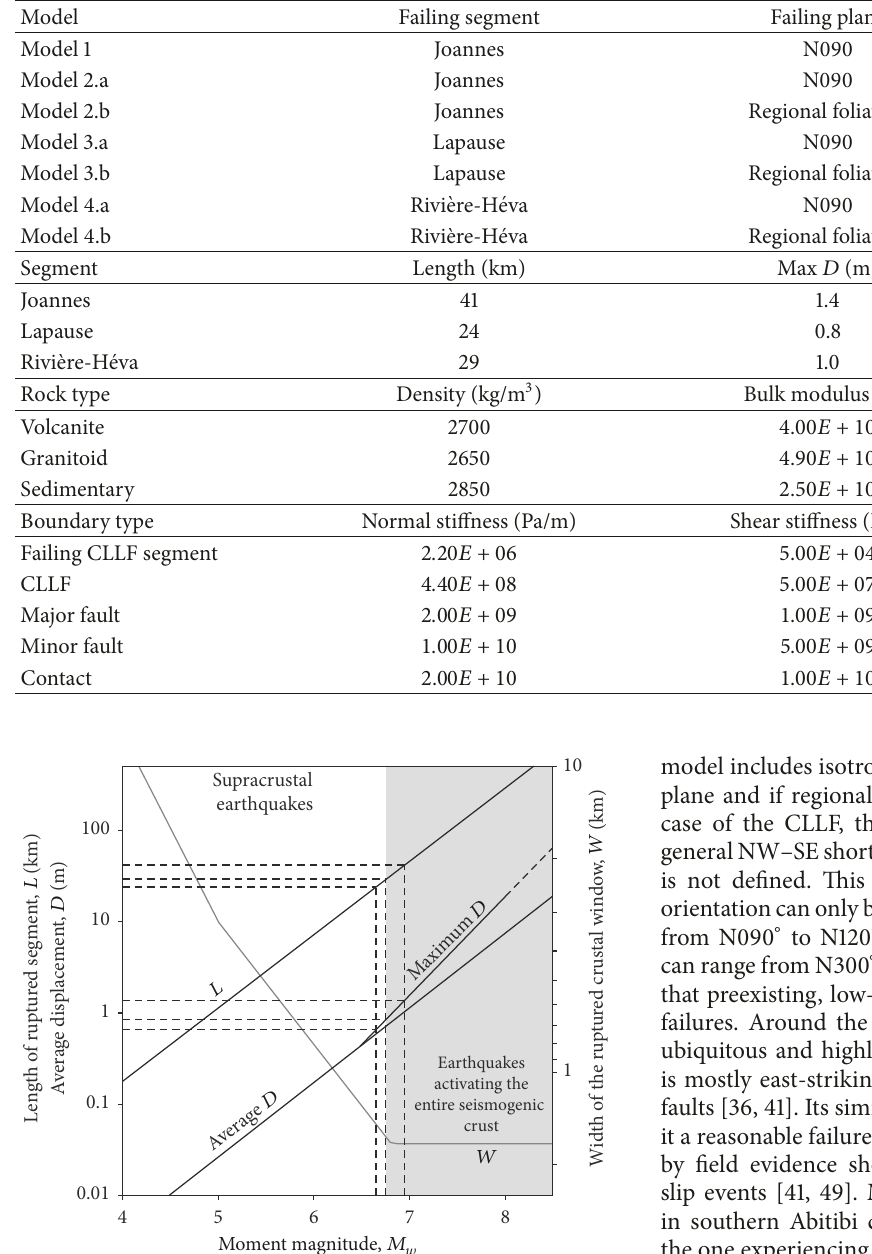
Table 1: Parameters of each model and related segments.